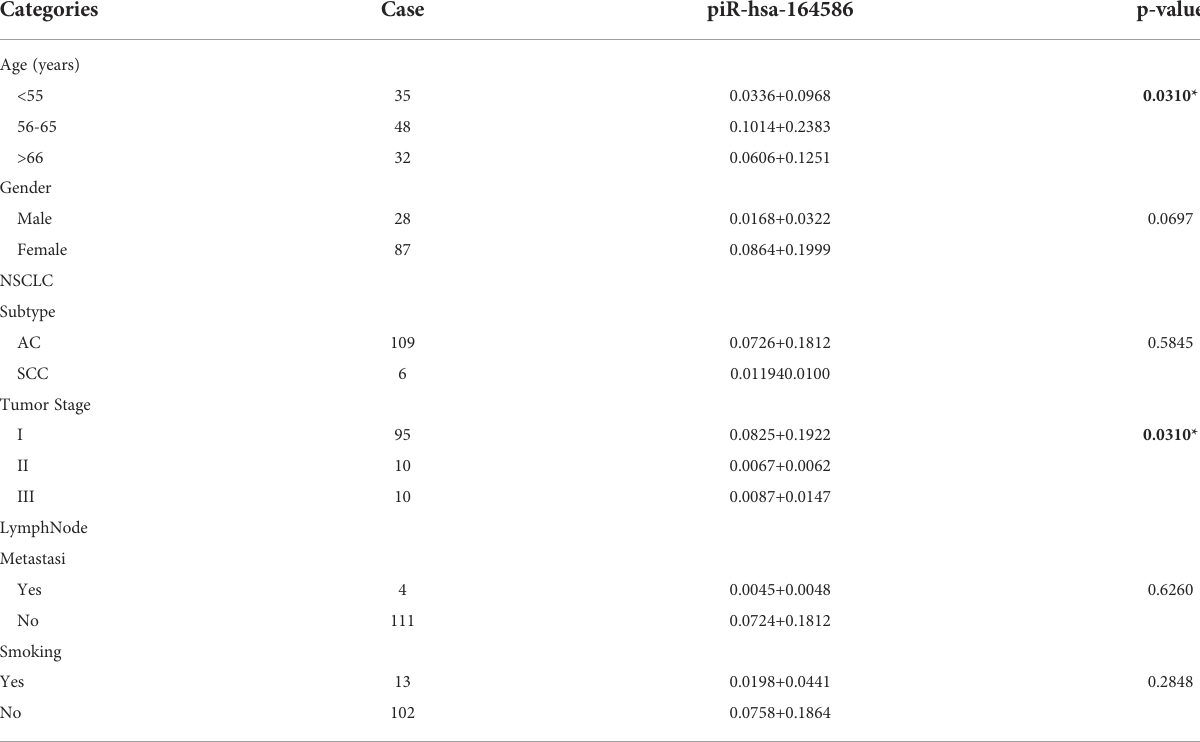
TABLE 2 Correlation between piR-hsa-164586 levels (2 D CT ) and clinical characteristics of patients with NSCLC (Mean+Standard Deviation).